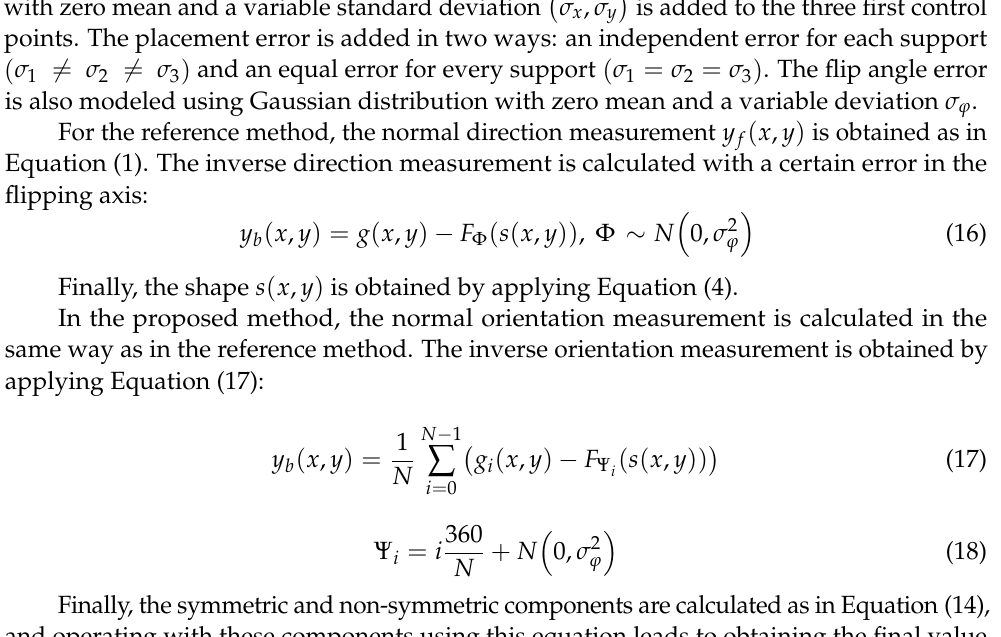
(cid:0) (cid:1) (𝑥, 𝑦) is obtained as σ x , σ y is added to the three first (cid:3033)